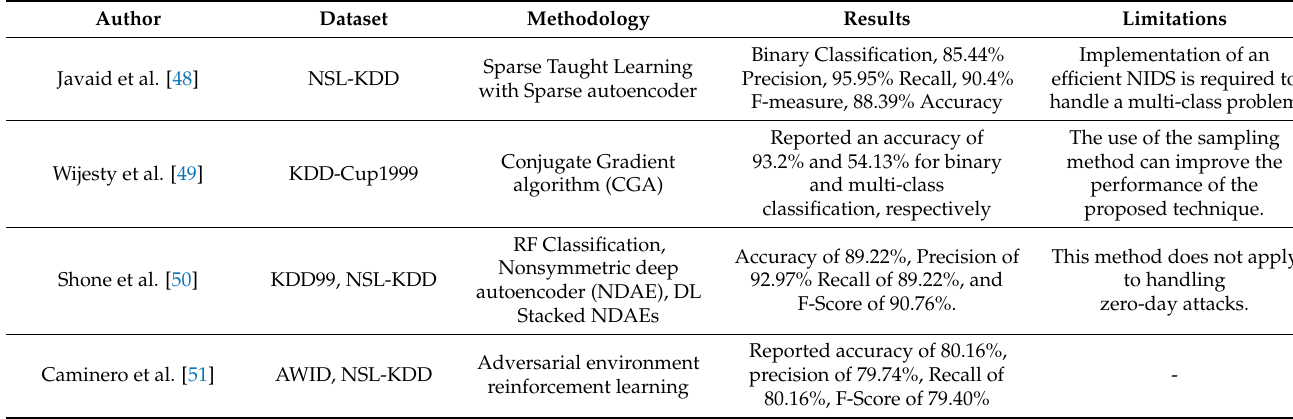
Table 5. Comparison with Existing Techniques.